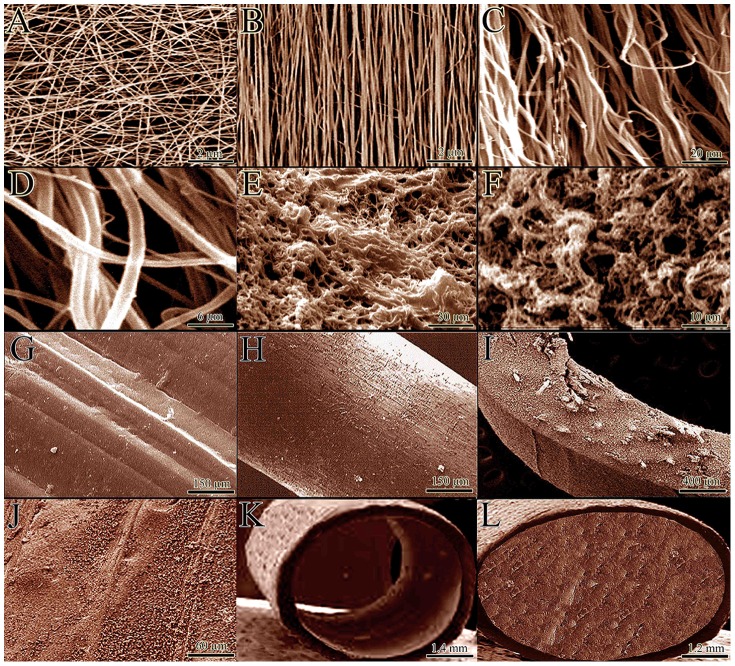
Morphology of the implants.A: Non-aligned electrospun collagen fibers constructed by electrospinning without dual plate device. B: Aligned electrospun collagen fibers were produced, using gap collector. C: Aligned internal architecture of the polymerized collagen fibers in the gel. D: The composition of the collagen implant at a larger magnification. E and F: Transverse section of the collagen implant after crosslinking. Most of the implant is filled with the polymerized collagen fibers while little porosity exists between these fibers. G: Surface of the collagen implant after crosslinking. H–J: Surface of the polydioxanone sheath. Note that there is no porosity in the external and internal architecture of the polydioxanone sheath. K: Circular polydioxanone sheath. L: Polydioxanone plate was melted and wrapped around the collagen implant to produce a collagen-PDS scaffold. PDS sheath could be seen at periphery while the collagen implant is seen in the center.